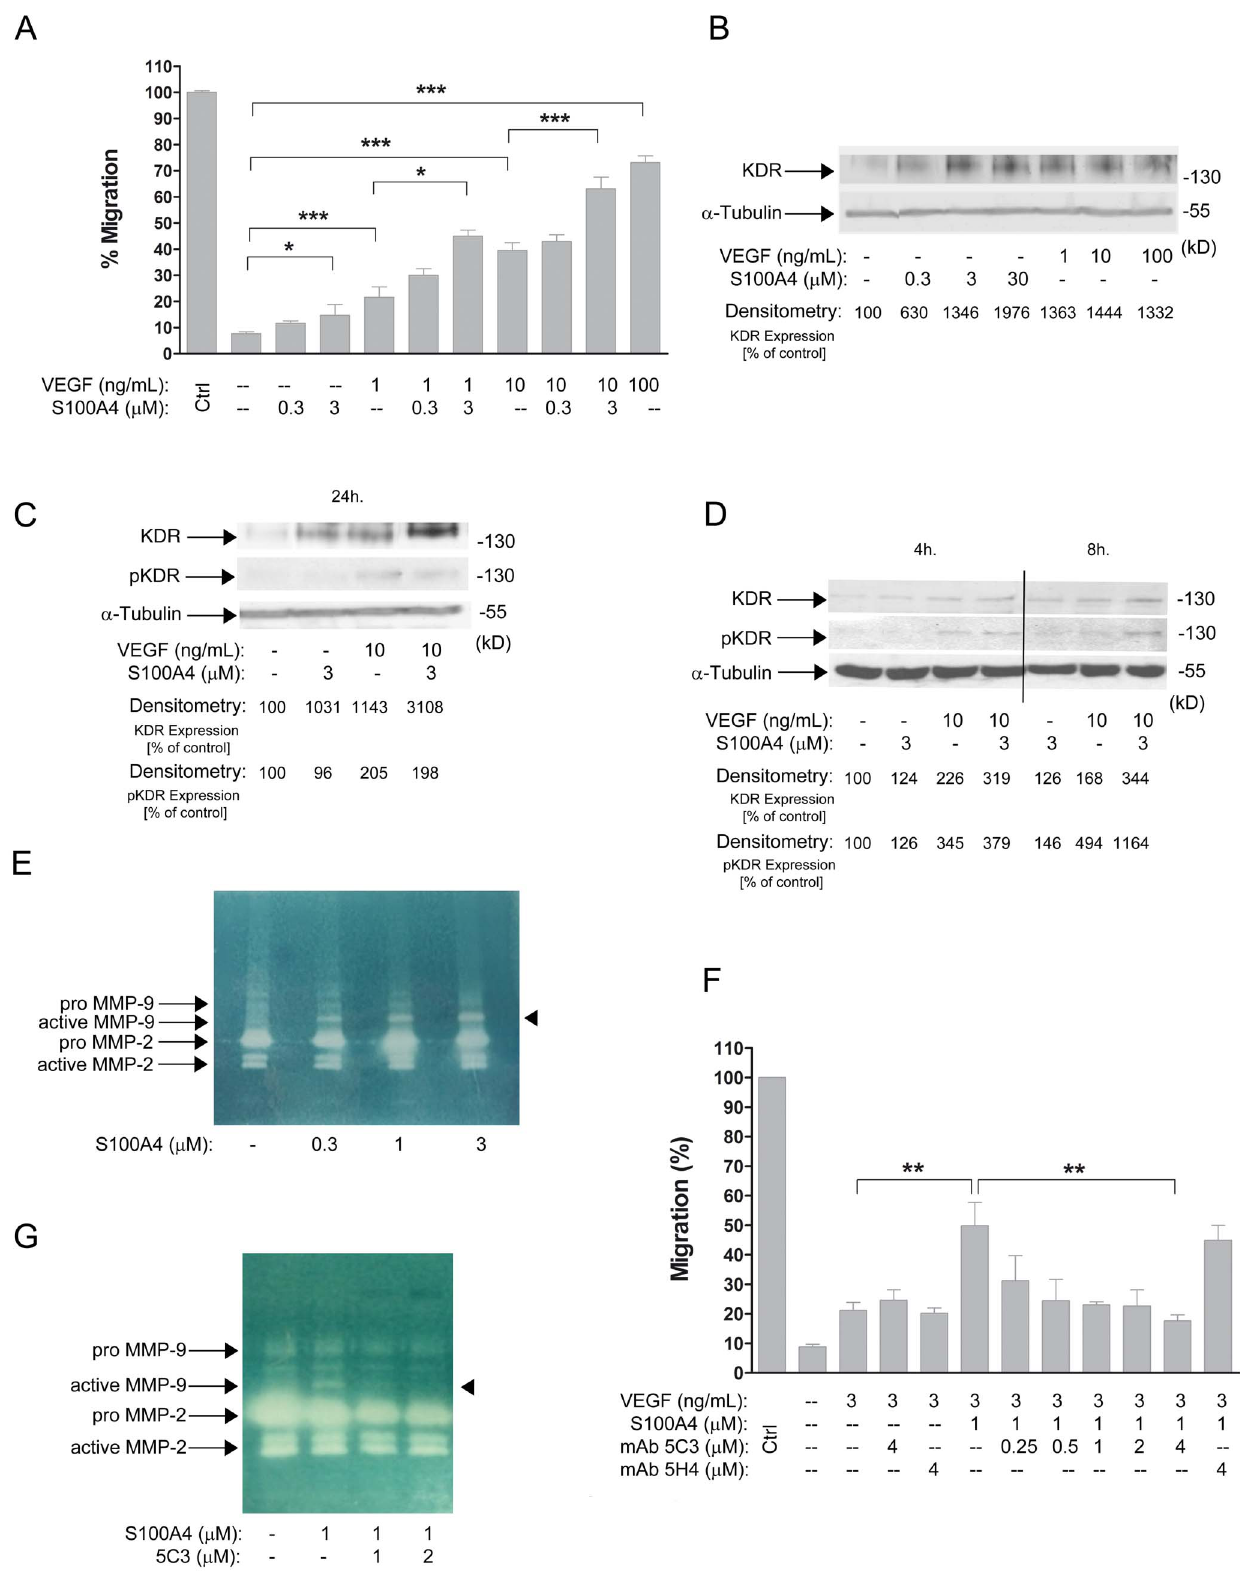
Figure 1. S100A4 acts synergistically with VEGF on HUVEC migration, by increasing KDR expression and the production of active MMP-9. A) Dose-response of VEGF and S100A4. Cells were treated with EBM, S100A4, VEGF, or the combination of S100A4 plus VEGF for 24 h and migration was analyzed. B) Western-blot analysis of KDR expression after adding either S100A4 (0.3–30 m M) or VEGF (1–100 ng/mL) for 24 h. C) Levels of KDR expression and activation (phosphorylation) induced by VEGF (10 ng/mL), S100A4 (3 m M) or by the combination of the two proteins for 24 h